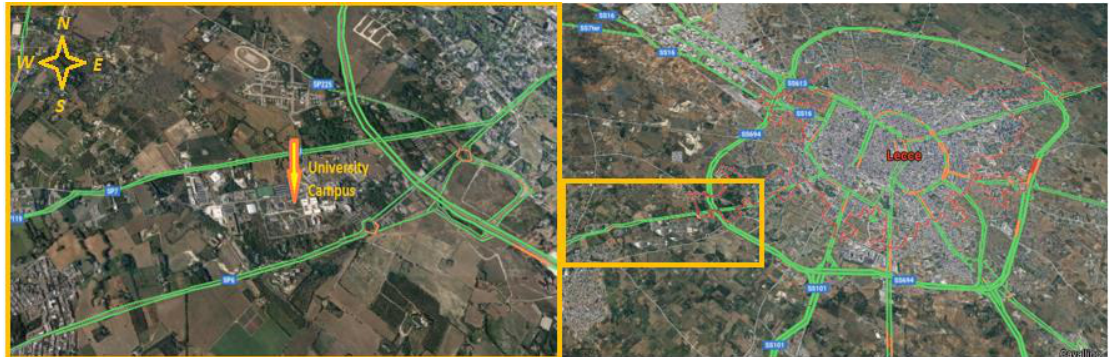
Figure 1. Location of the sampling site with respect to the city center of Lecce. The most important roads are shown in green.